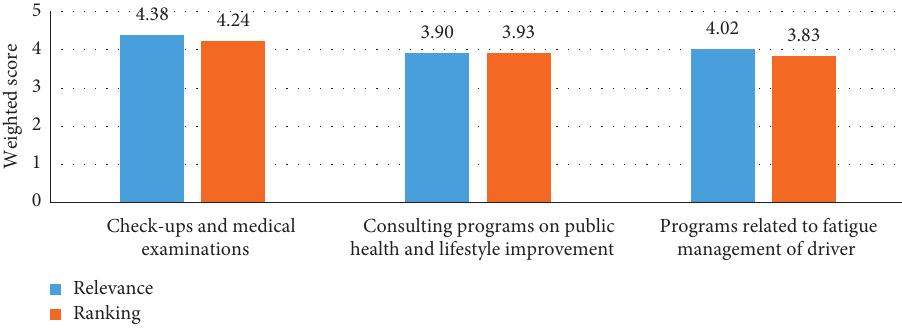
Figure 7: Weighted mean of relevance and priority ranking related to Question A6.